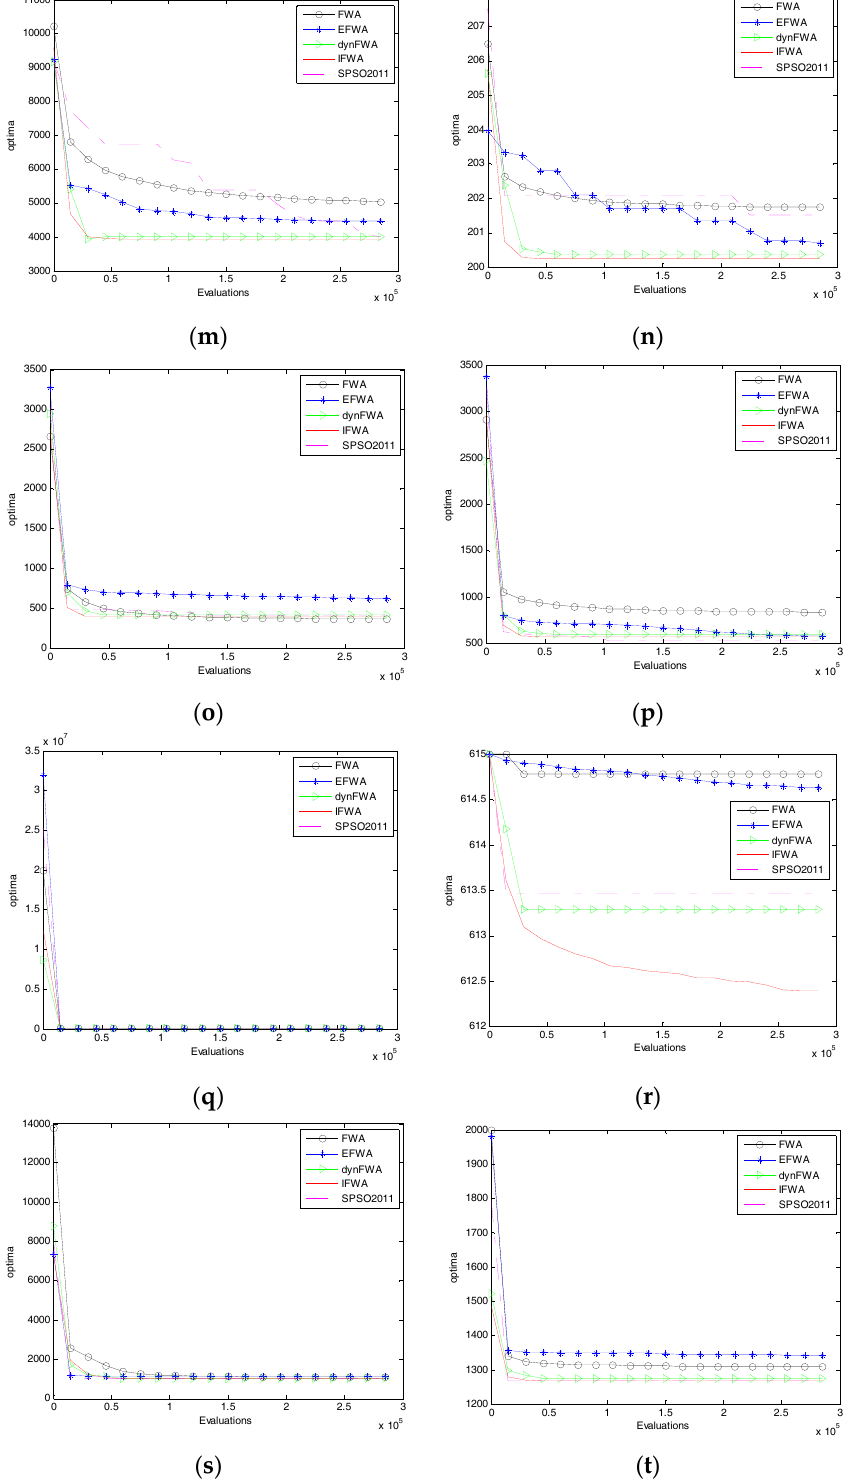
Figure A1. The FWA, EFWA, dynFWA, SPSO2011 and IFWA searching curves. ( a ) f1 function; ( b ) f3 function; ( c ) f4 function; ( d ) f5 function; ( e ) f6 function; ( f ) f7 function; ( g ) f8 function; ( h ) f9 function; ( i ) f10 function; ( j ) f11 function; ( k ) f13 function; ( l ) f14 function; ( m ) f15 function; ( n ) f16 function; ( o ) f17 function; ( p ) f18 function; ( q ) f19 function; ( r ) f20 function; ( s ) f21 function; ( t ) f24 function.